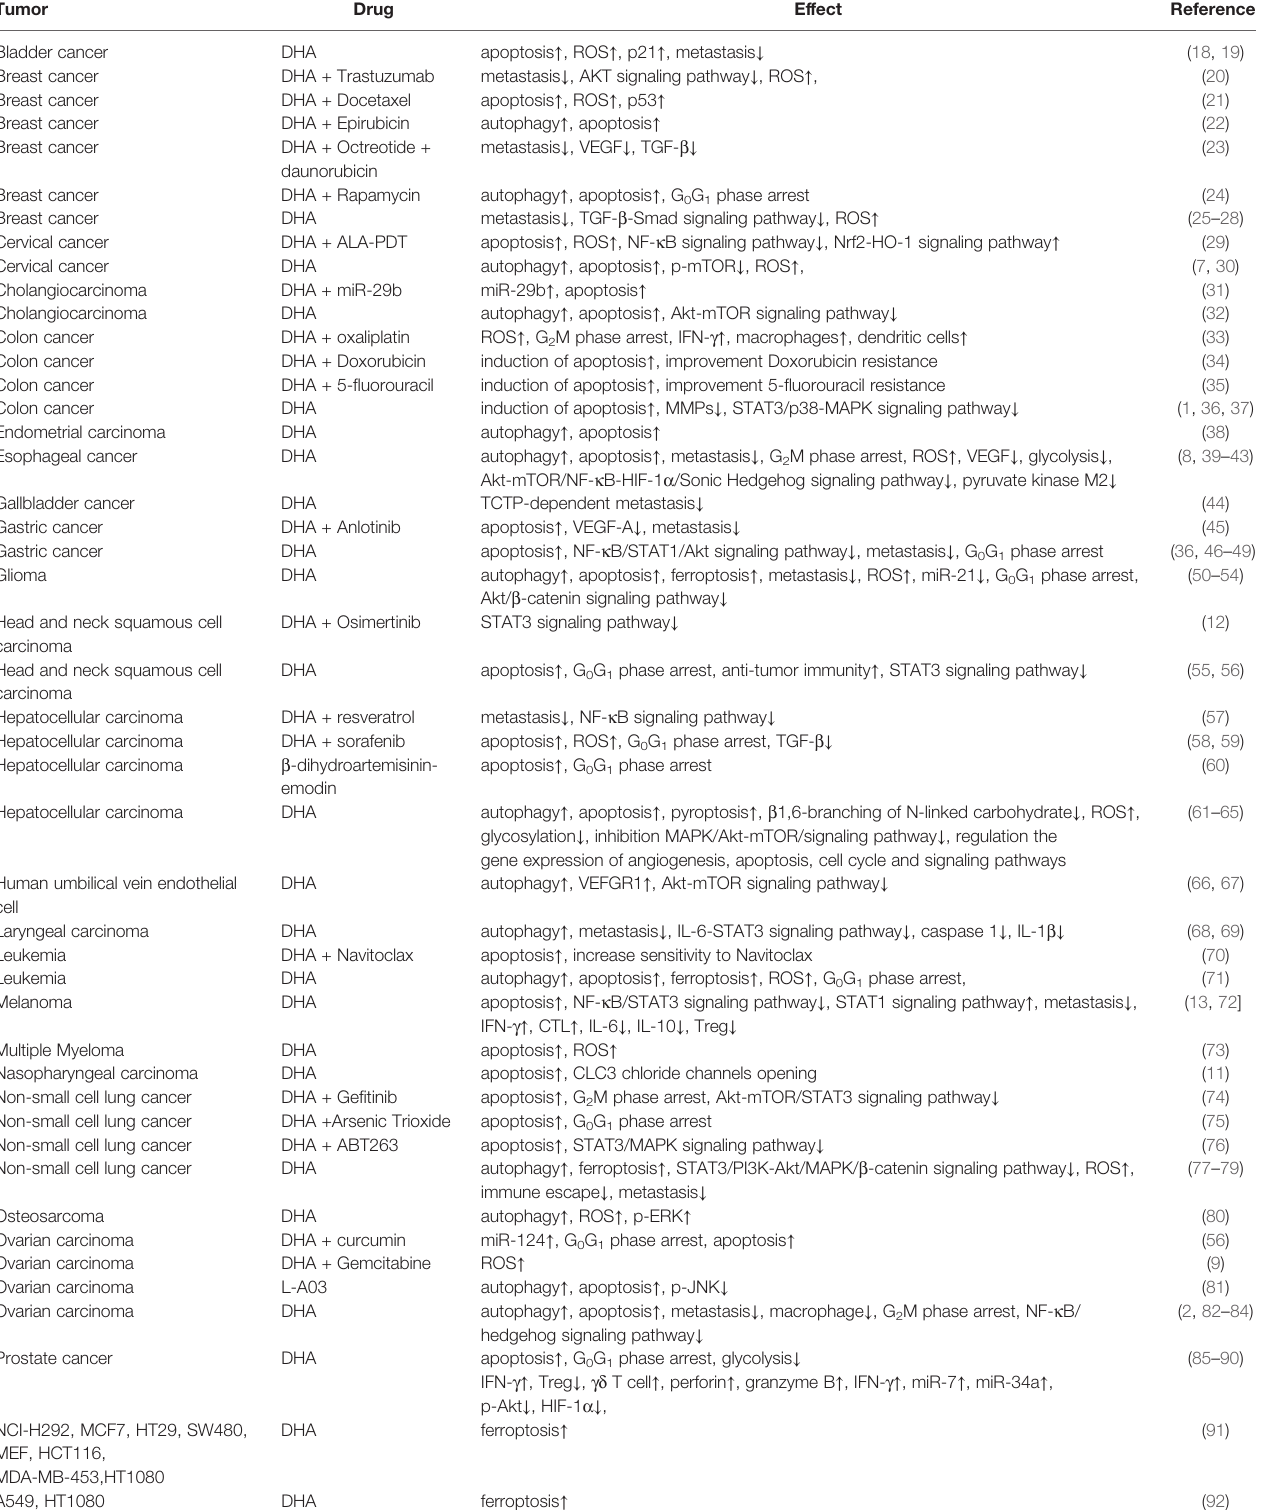
TABLE 1 | The effects of DHA on tumors.